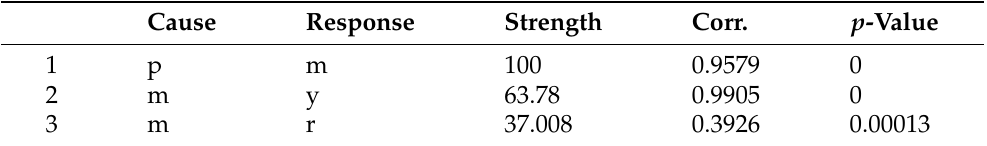
Table 4. The dependent variable m is in the cause column when paired with y and r. Therefore, they have an endogeneity problem. Algorithm: generalCorr::causeSummBlk() . Cause Response Strength Corr. p -Value 1 p m 100 0.9579 0 2 m y 63.78 0.9905 0 3 m r 37.008 0.3926